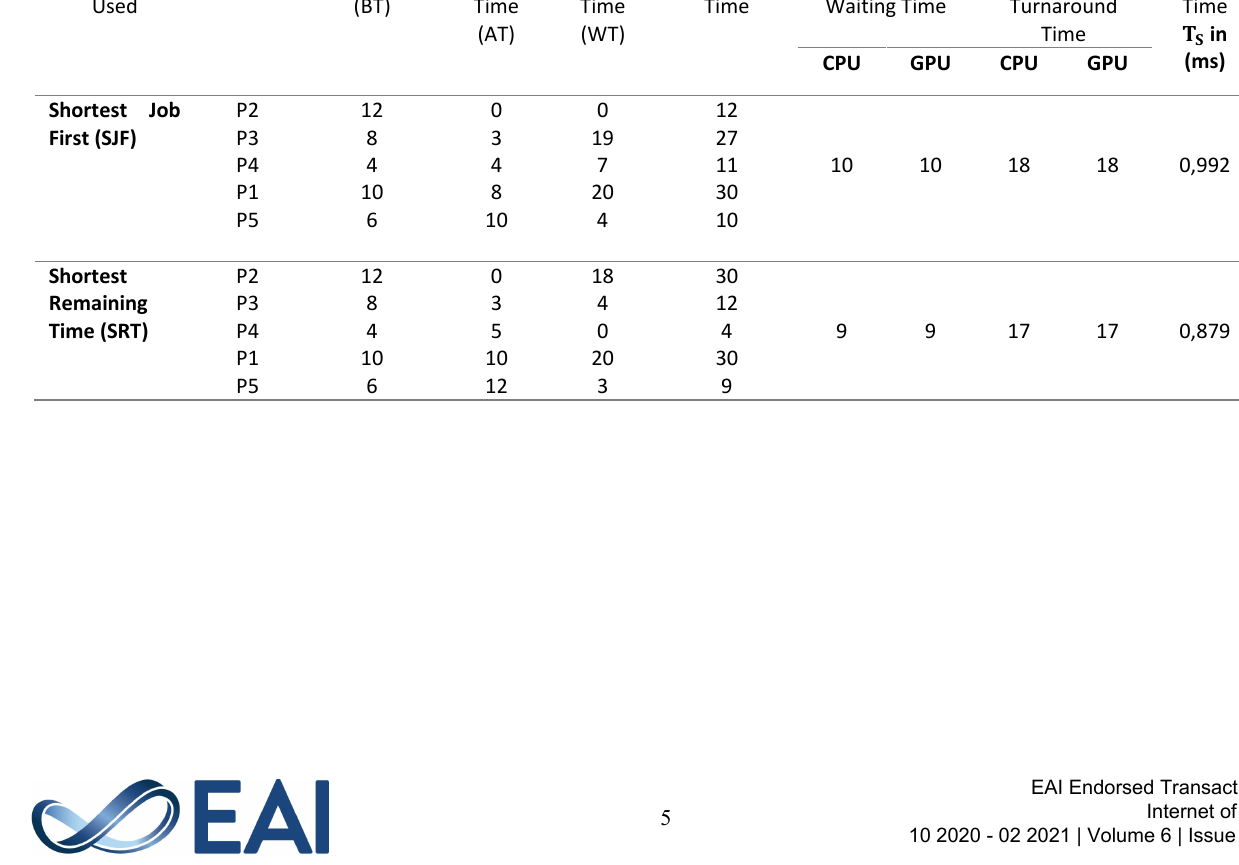
Table 1. The different performances of the implementation of the SRT and SJF algorithms on GPU and CPU